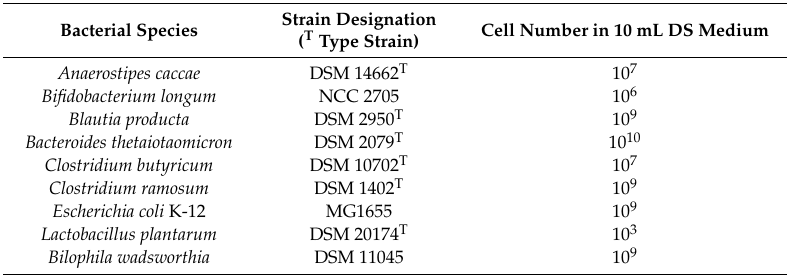
Table 5. Bacterial strains used and cell numbers transferred to